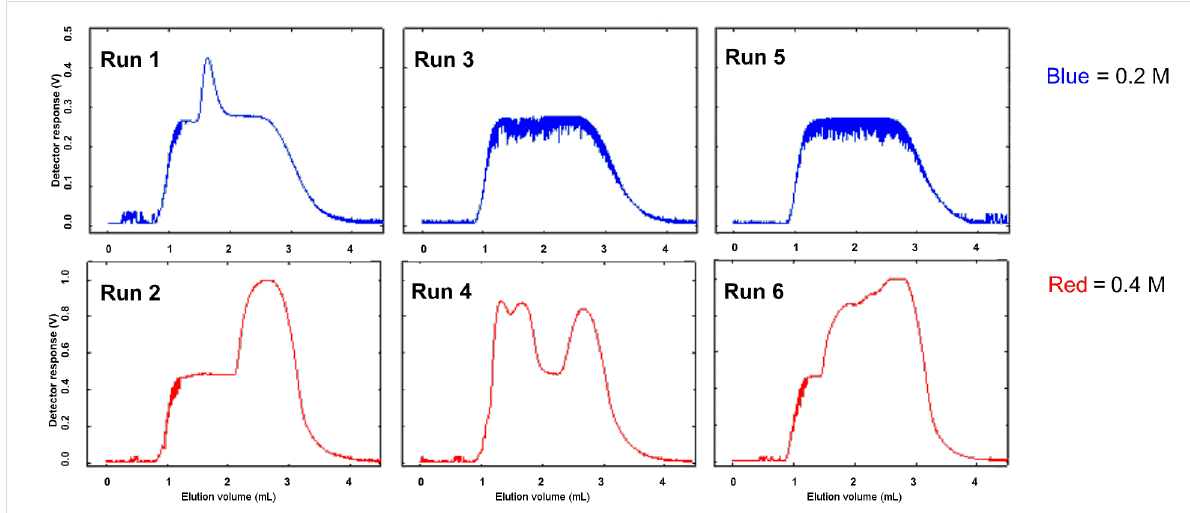
Figure 2: Variation in UV absorbance during the reduction of styrene to ethylbenzene, in the controlled mode on SAH 3 , demonstrating variable hydrogen availability. Reactions were carried out through a 10% Pd/C 30 mm CatCart ® , at pressure setting 80 bar, MeOH, with flow rate 1.0 mL/min, and temperature 35 °C, and were monitored at 265 nm.